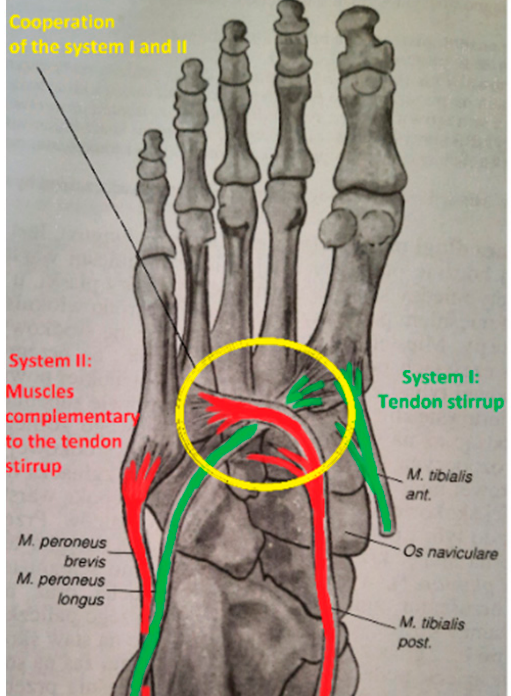
Figure 1. Two systems of the muscles. System I (green)—tendon stirrup consisting of tibial anterior and fibularis longus muscles. System II (red)—muscles complementary to the tendon stirrup consisting of the m. tibial posterior and m. fibularis brevis. Muscles from system I and system II that cooperate are marked with a yellow circle. Own elaboration based on a drawing from [13].